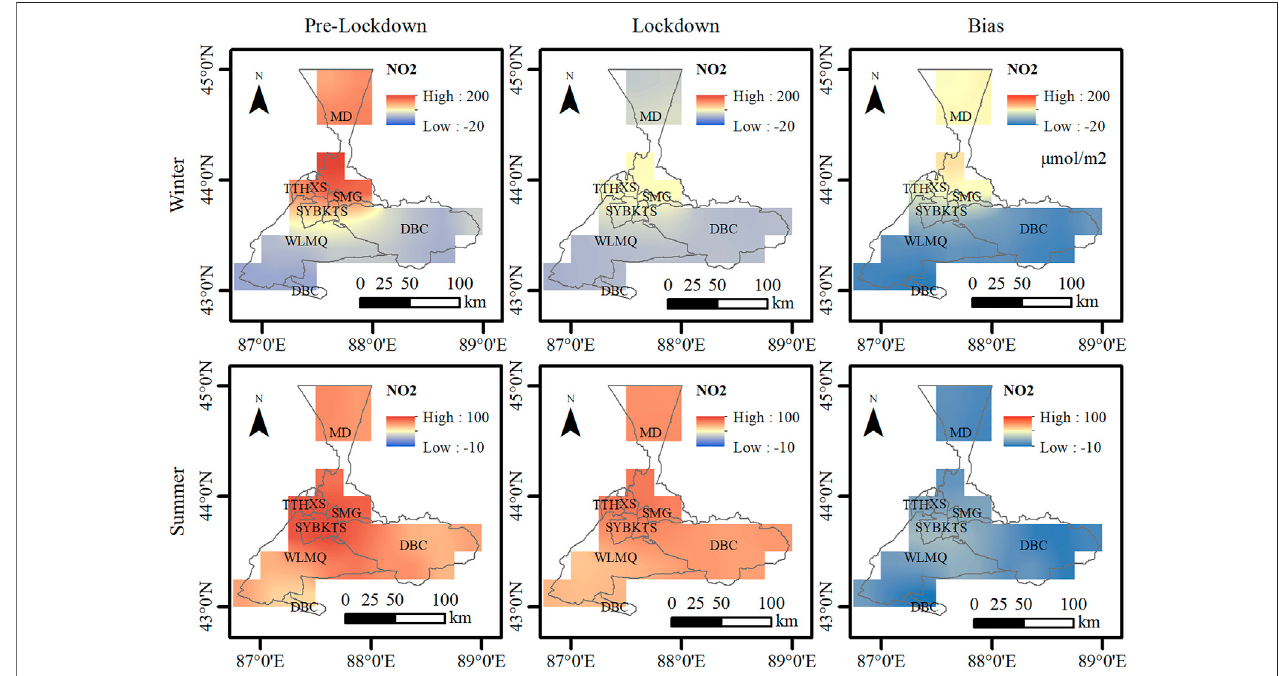
FIGURE 4 | The changes in tropospheric NO 2 ( μ mol m − 2 ) in the study region before and during the winter and summer lockdowns, showing the bias before the lockdown minus the lockdown.